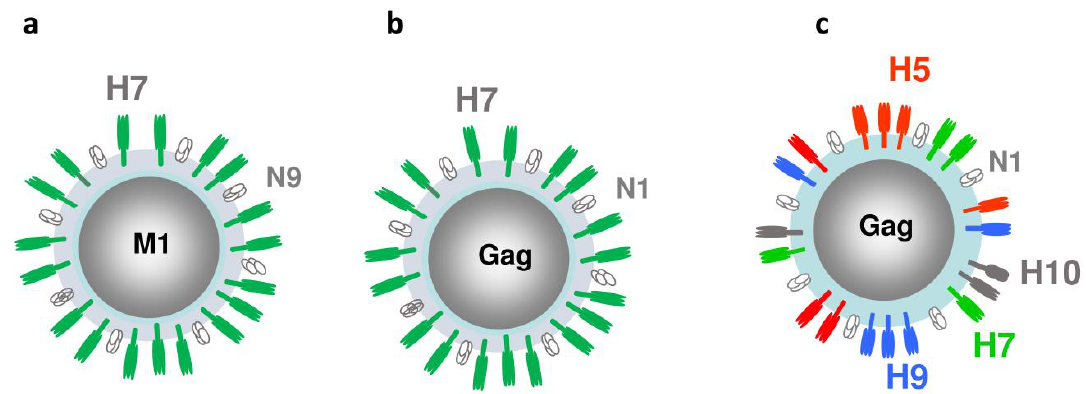
Figure 3. Structural proteins in mono- and quadri-subtype VLPs. ( a ) Mono-subtype H7N9 VLP with H7, N9 and M1 genes; ( b ) Mono-subtype chimeric H7N1 VLP with H7, N1, and Gag genes; ( c ) Quadri-subtype VLPs co-localizing H5, H7, H9 and H10 subtypes along with N1 and Gag within a VLP.